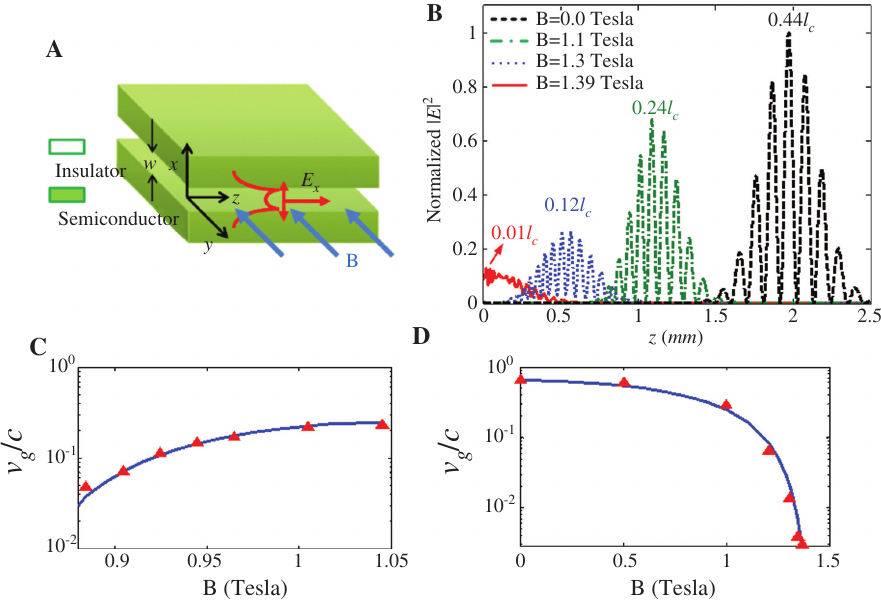
Figure 8: A terahertz (THz) tunable slow-light system. (A) Schematic structure of the slow-light system (from [75]). (B) FDTD simulations of THz pulses propagating in the slow-light waveguide. The frequency of the incident wave is 1 THz. When the magnetic fields are 0, 1.1, 1.3, and 1.4 Tesla, the peak of the pulse moves 0.01 l = 15 ps × c . (C) and (D) (from [75]): Group velocity of a monochromatic wave tuning by the magnetic field. f = 1 THz (in the lower defined as l c band) and f = 3 THz (in the higher band),